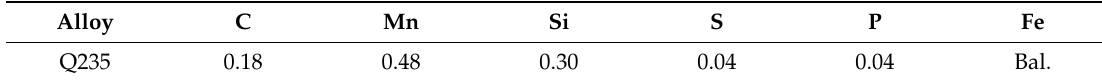
Table 2. Chemical composition of Q235 steel